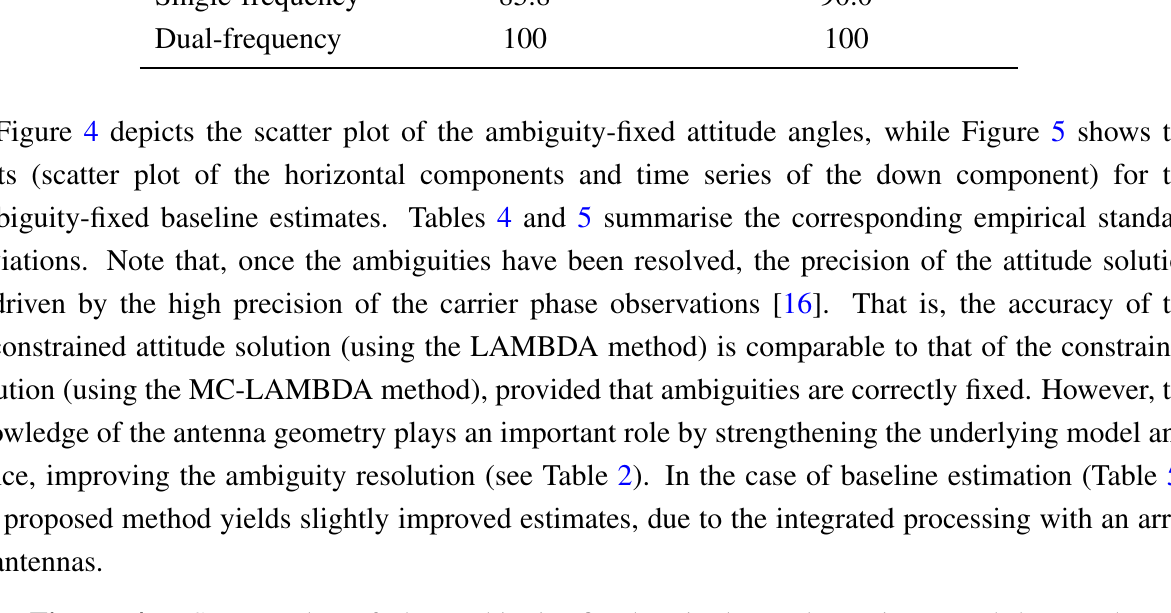
Scatter plot of the ambiguity-fixed attitude angles using epoch-by-epoch processing of the static data (0.6-m